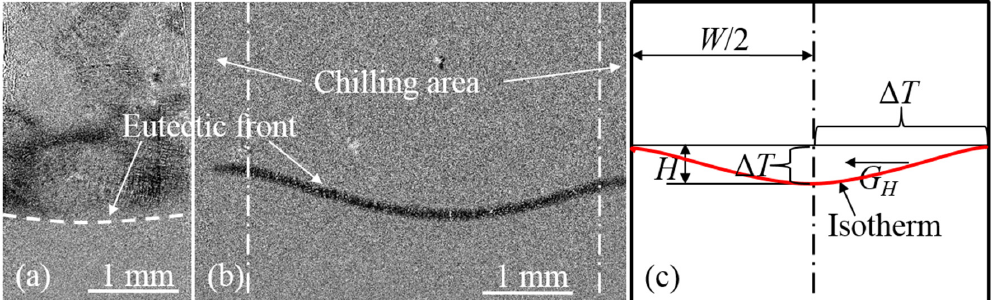
Figure 4. The eutectic front of the two geometries of thin-walled samples: ( a ) 2 mm sample; ( b ) 5 mm sample; ( c ) Schematic of symmetrized isotherm.